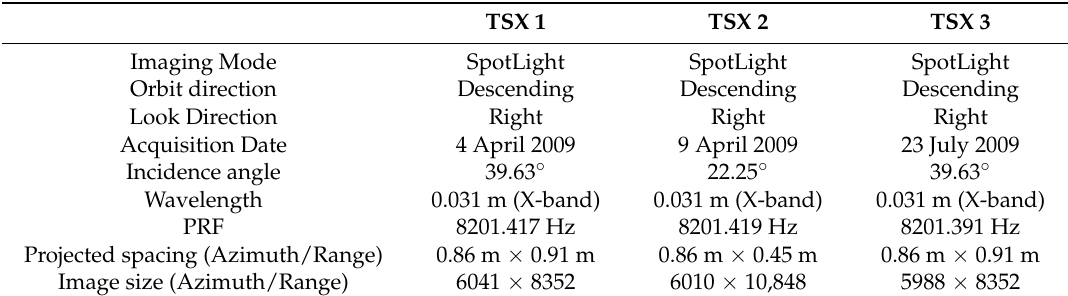
Table 1. TerraSAR-X (TSX) image information.